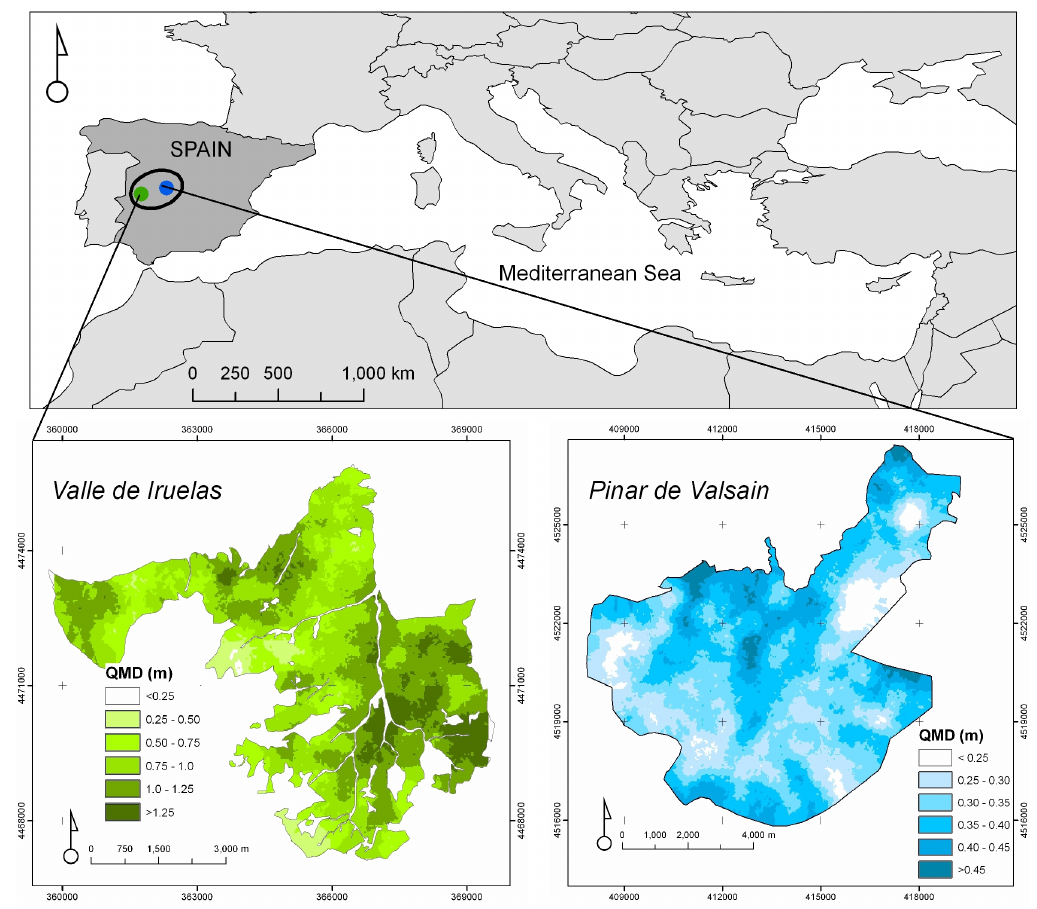
Figure 2. Location of the study sites. Insets show QMD values as kriged from inventory plots in the treed areas of Valle de Iruelas and Pinar de Valsaín . Subset areas covered by 834 plots in Valsaín and 661 plots in Iruelas were investigated in the